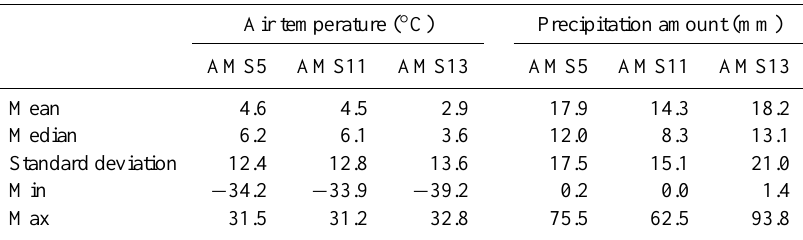
Table 2. Statistics for air temperatures and precipitation amount at the AMS5, AMS11, and AMS13 sites in the Athabasca oil sands region. Hourly air temperatures were obtained from the Clean Air Strategic Alliance (CASA) Data Warehouse website. Air temperature ( ◦